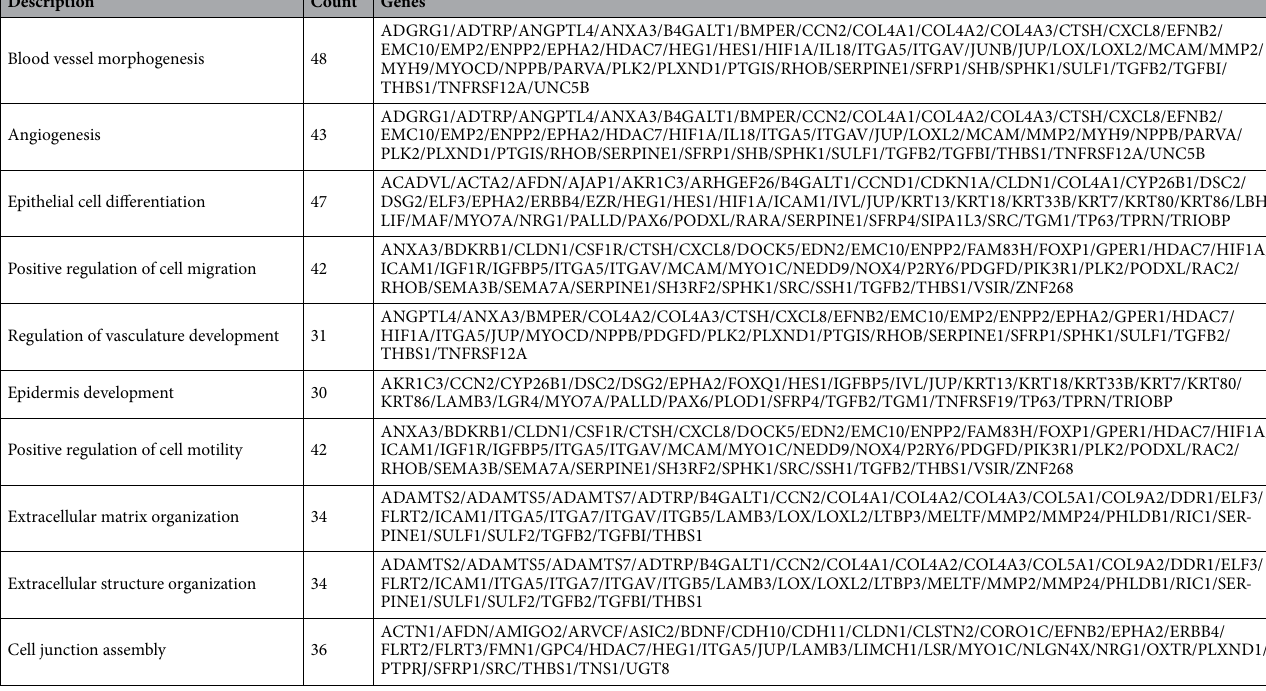
Table 1. Gene Set Enrichment Analysis was performed on differentially expressed transcripts in ARPE-19 cells with modified EMP2 levels, with the top 10 Go ontology terms from Group 1 (KD < WT < EMP2) shown.